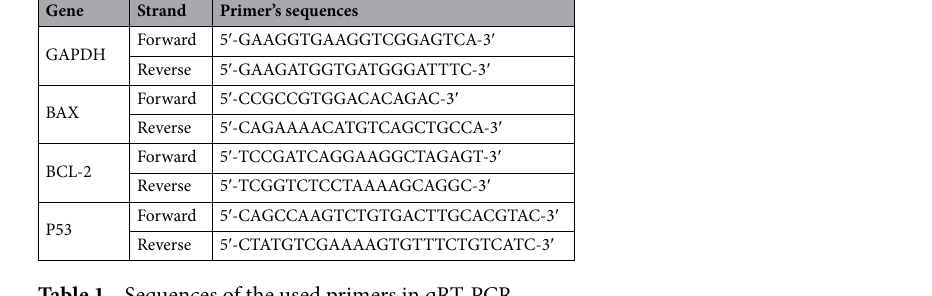
Table 1. Sequences of the used primers in